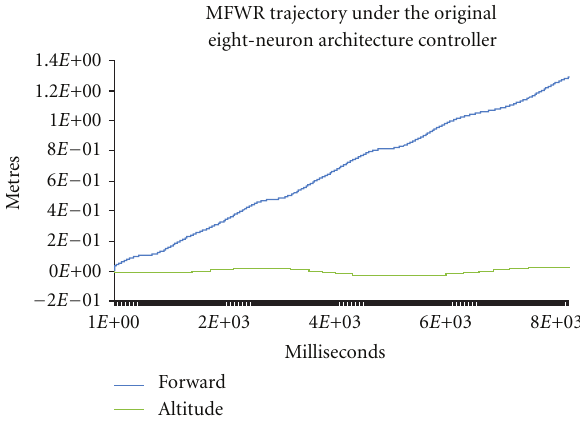
Figure 24: The MFWR trajectory produced by the original fully connected eight-neuron nonautonomous controller. It can be observed that the evolved controller was successful in producing forward motion in the MFWR without any overall gain in the altitude.